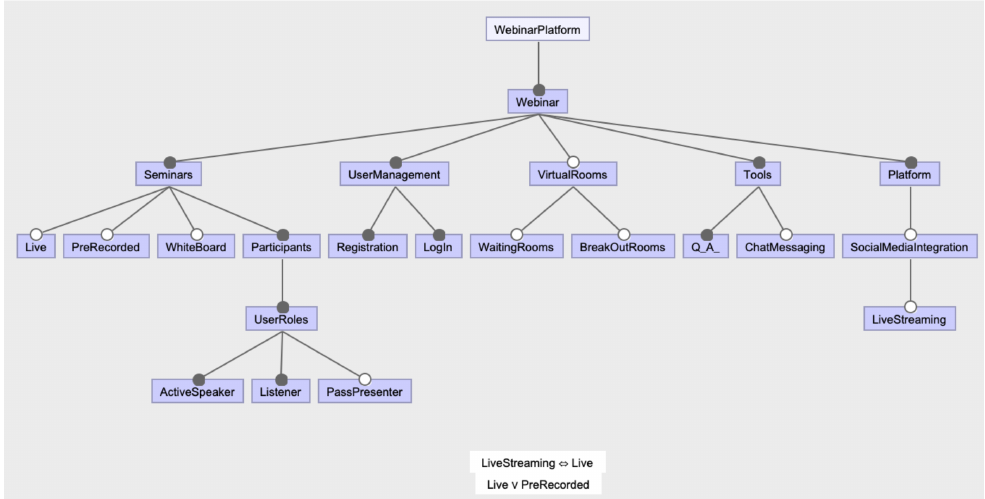
Figure 5. Webinar system domain feature